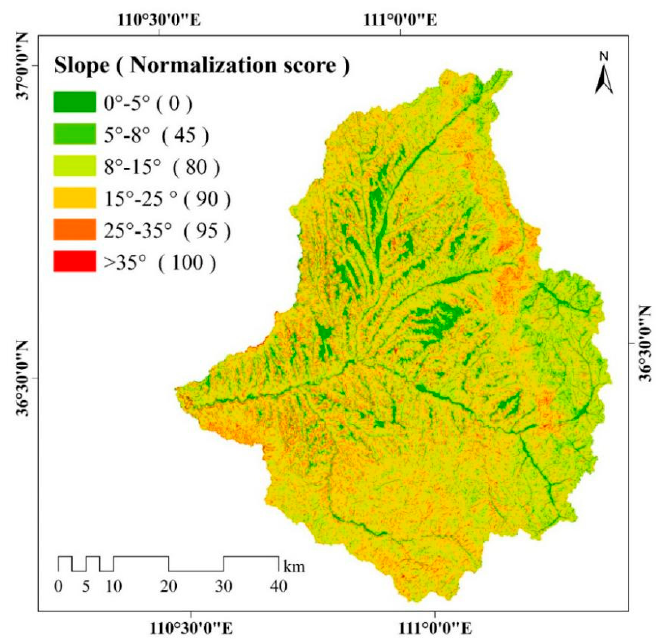
Figure 6. Spatial distribution of slope gradient in the study area. Slope gradient is classified into 0°–5°, 5°–8°, 8°–15°, 15°–25°, 25°–35°, and >35°. The different colors represent different slope classes. A higher normalization score of the slope represent a greater impact on soil erosion.